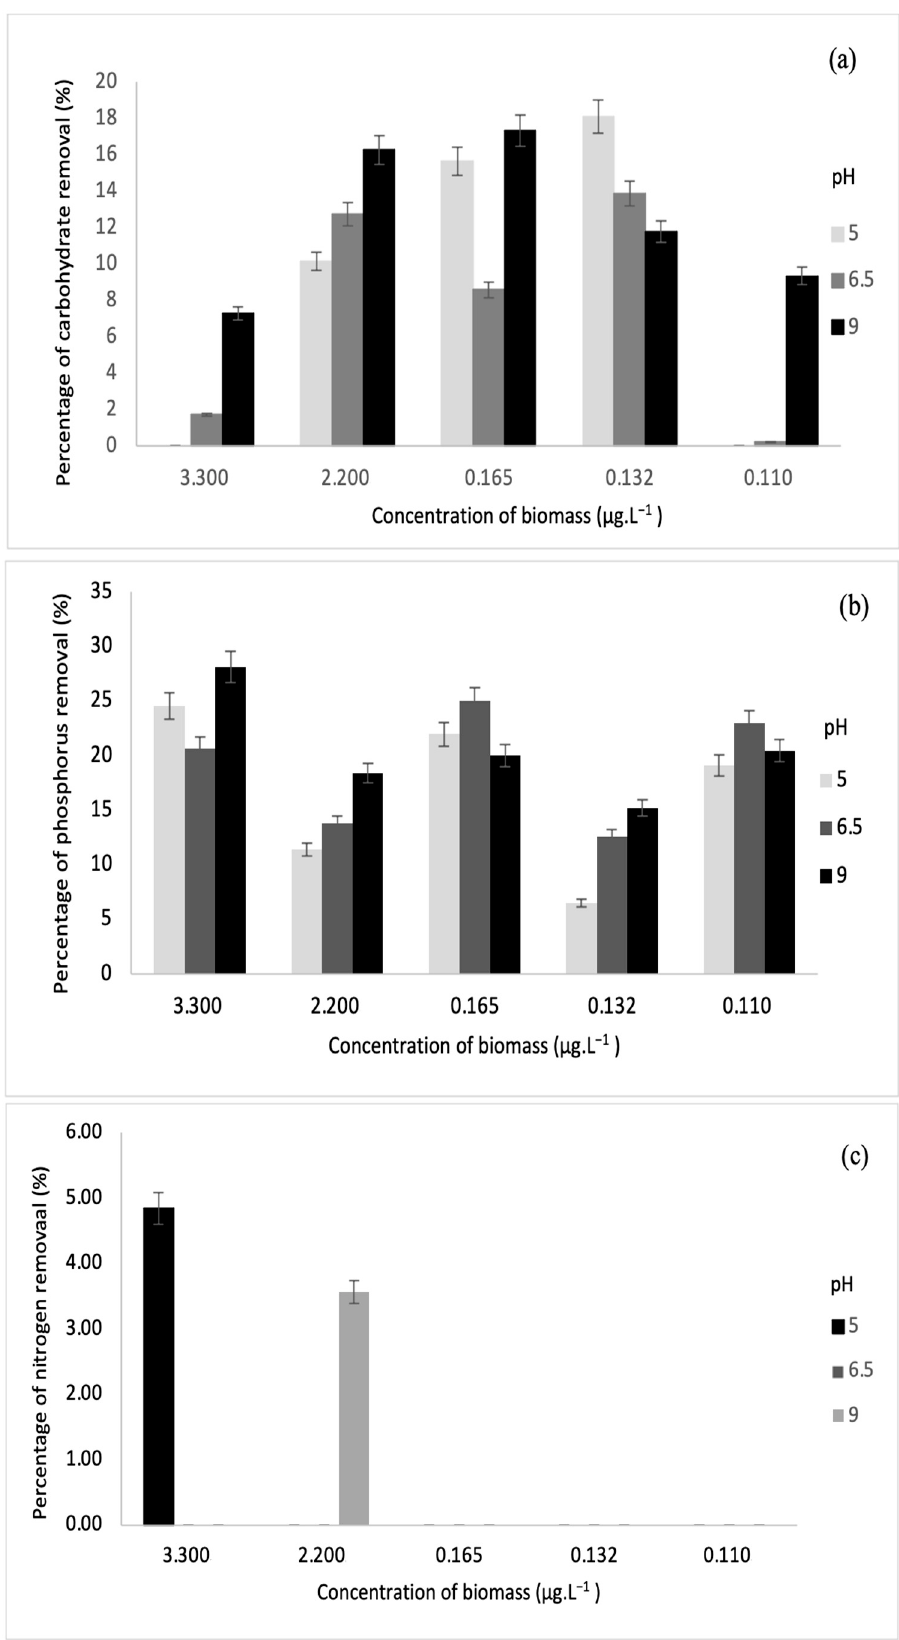
Figure 7. Relationships between biomass concentrations (with sonication) and ( a ) carbohydrate removal, ( b ) phosphorus removal, and ( c ) nitrogen